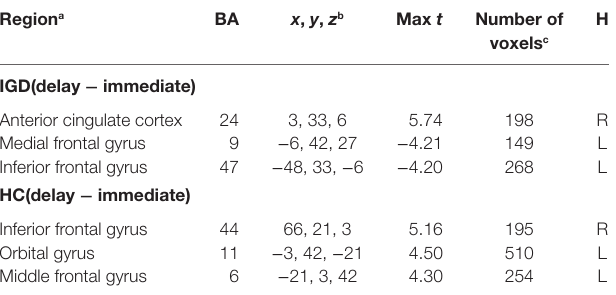
Table 3 | Brain activations change between different conditions in IGD and HC. region a